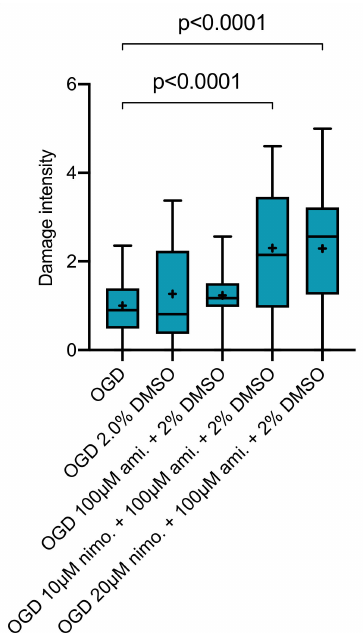
Figure 5. Slices receiving a combination of either 10 ( n = 47) or 20 µ M ( n = 46) nimodipine with 100 µ M amiloride in 2.0 Vol.% DMSO showed significant impairment of cell viability at 72 h (Kruskal–Wallis test with post hoc Dunn’s test, p < 0.0001) compared to OGD slices ( n = 96). This e ff ect was not observed for slices receiving 100 µ M amiloride in 2.0 Vol.% DMSO ( n = 43) or 2.0 Vol.% DMSO alone ( n =